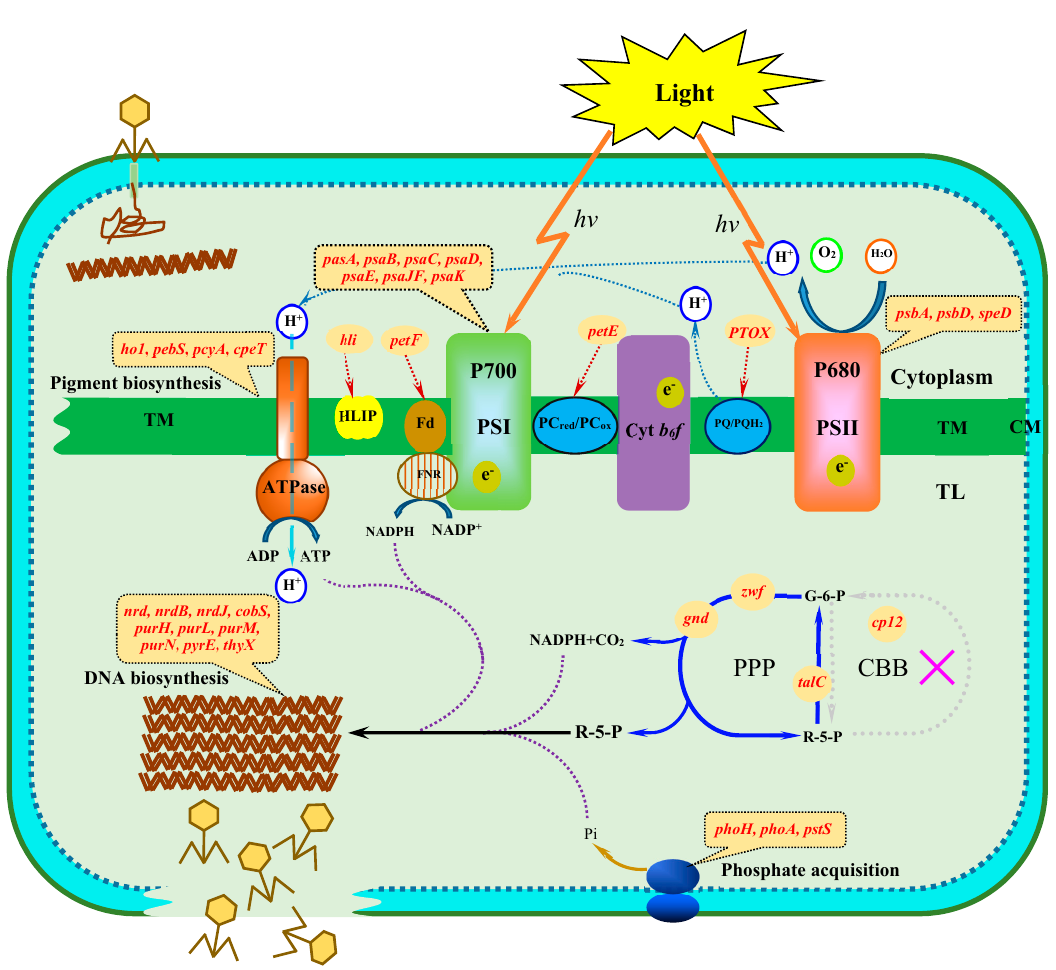
Figure 1. Model of the metabolic pathways regulated by cyanophage host ‐ like genes in infected cyanobacterial cells. Cyanophage host ‐ like genes are marked in red. Abbreviations: TM, thylakoid membrane; TL, thylakoid lumen; CM, cell membrane; PSI, photosystem I; PSII, photosystem II; PPP, pentose phosphate pathway; CBB, Calvin–Benson–Bassham; HLIP, high light ‐ induced protein; PQ, plastoquinone (oxidized); PQH 2 , plastoquinone (reduced); PTOX, plastoquinol terminal oxidase; Cyt b 6 f , cytochrome b 6 f complex; PC red , plastocyanin (reduced); PC ox , plastocyanin (oxidized); FNR, ferredoxin ‐ NADP reductase; Fd, ferredoxin; G ‐ 6 ‐ P, glucose ‐ 6 ‐ phosphate; R ‐ 5 ‐ P, ribose ‐ 5 ‐ phosphate.